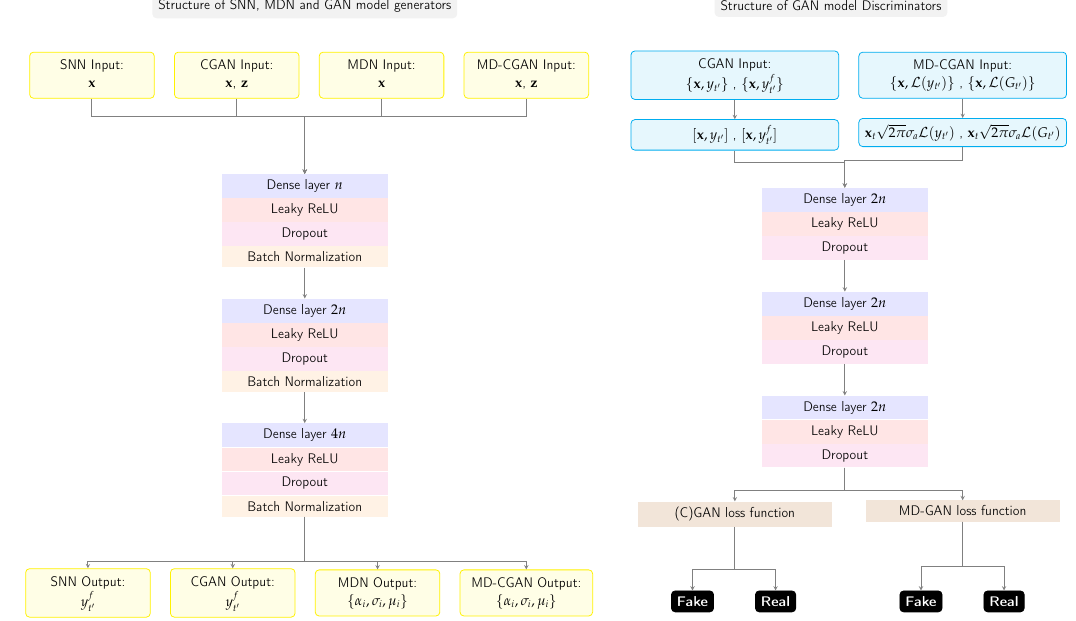
Figure 3. Common Neural Network structure used across all